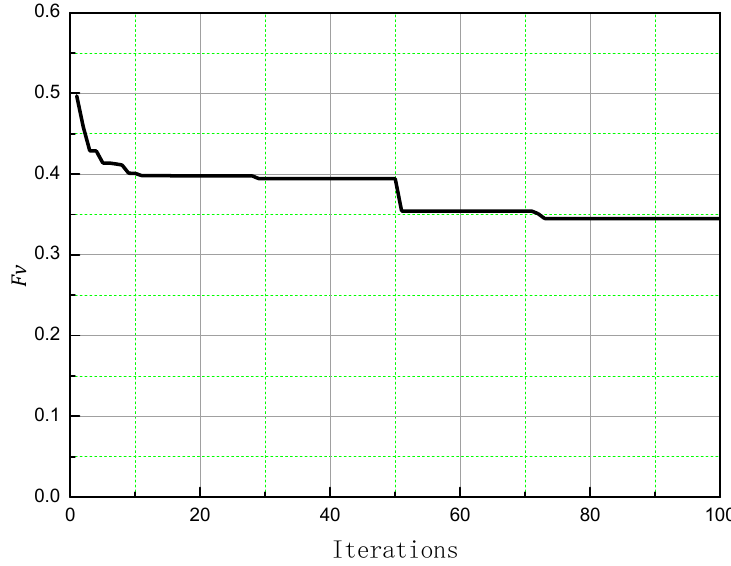
Figure 12. Variations of the optimal individual.